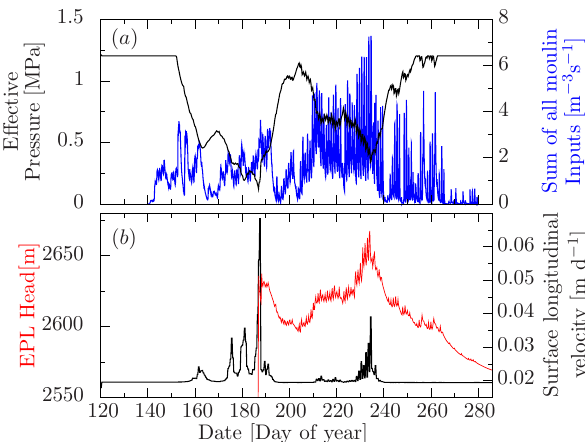
Fig. 13. Evolution during the spring speed-up event for different values of the parameter C of the effective pressure (a) and surface longitudinal velocity (b) at the reference point, depicted in Fig. 4.